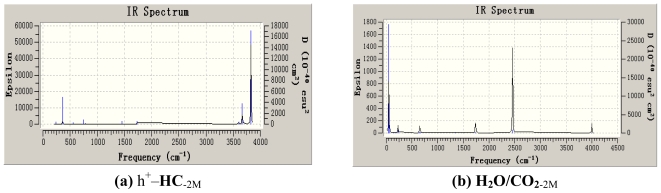
IR Spectrum of the complexes at MP2/6–311G* Level (GV 4). (a) h+–HC−2M; (b) H2O/CO2-2M; (c) h+–HC−1M; (d) e–HC−1M; (e) H2O/CO2-1M; (f) e–HC−2M.